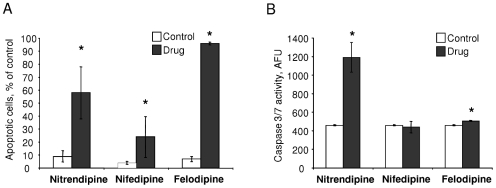
Candidate agents induce apoptosis in malignant cholangiocytes.Apoptosis was assessed morphologically and biochemically in Mz-ChA-1 cells incubated with felodipine (20 µM), nitrendipine (30 µM), or nifedipine (20 µM) for 24 hrs. Panel A: The number of cells with nuclear morphological features of apoptosis was counted using fluorescence microscopy after staining with DAPI, and is expressed as a percentage of all cells counted in several high power fields. Results are from three separate experiments. * p<0.05 relative to controls. Panel B: Caspase 3/7 activation was assessed using a luminometric assay (Caspase-Glo 3/7 Assay, Promega Corp., Madison WI). Compared to controls, significantly higher caspase 3/7 activation was observed with felodipine or nitrendipine. Results are from four separate experiments. * p<0.05 relative to controls.